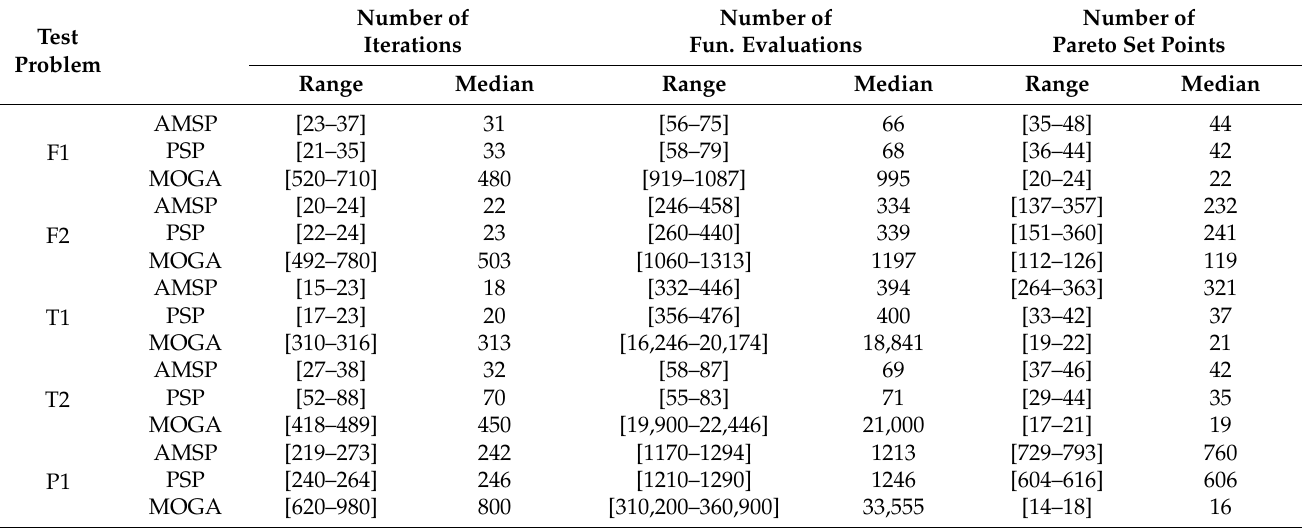
Table 4. Performance comparison of multi-objective optimization